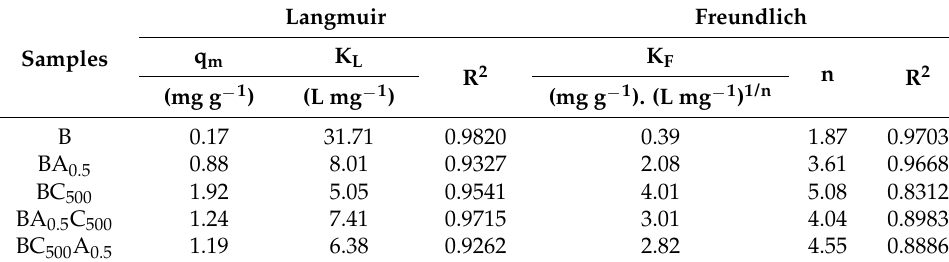
Table 8. Langmuir and Freundlich diuron adsorption isotherm constants.